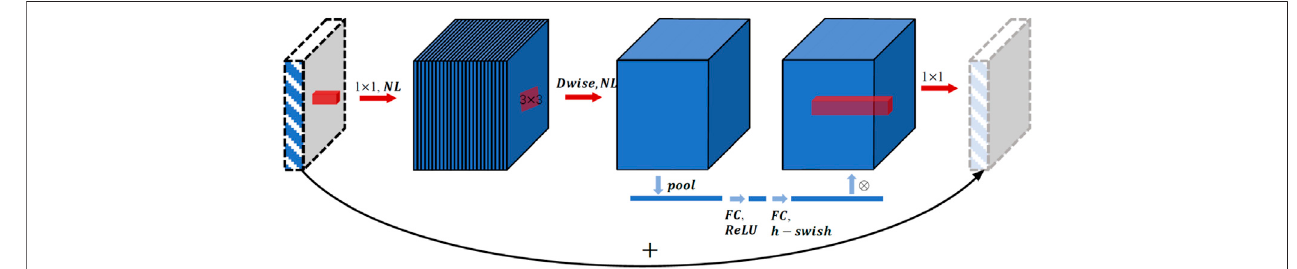
FIGURE 2 | Structure of BNECK.